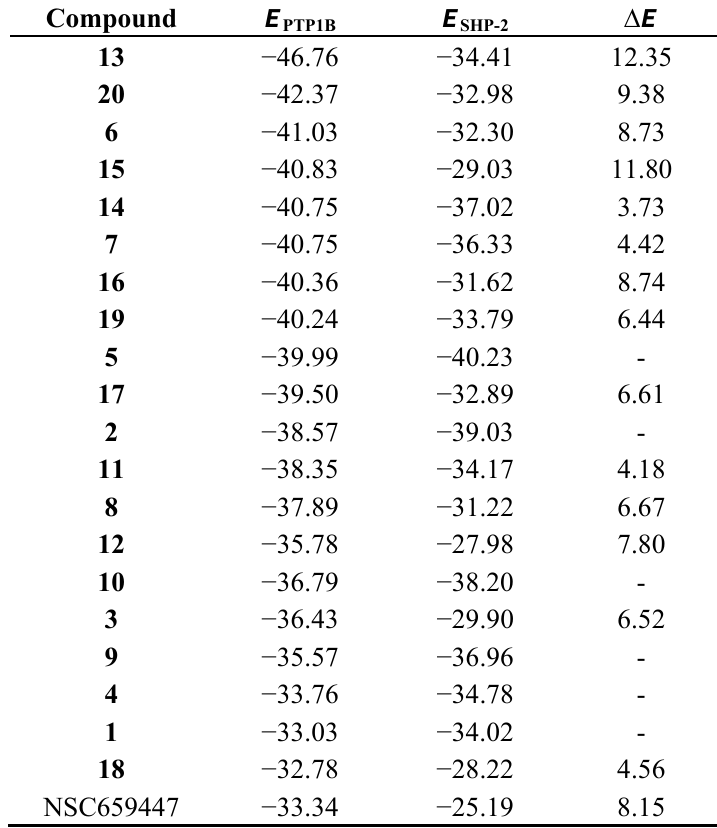
Table 1. Binding energies of 20 derivative compounds with PTP1B and SHP-2